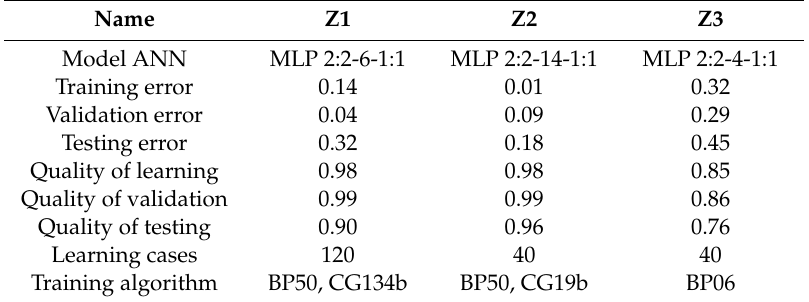
Table 2. Network structure created on the basis of the learning sets prepared for dried strawberry fruit. BP: Back-Propagation; CG: conjugate gradient algorithm.